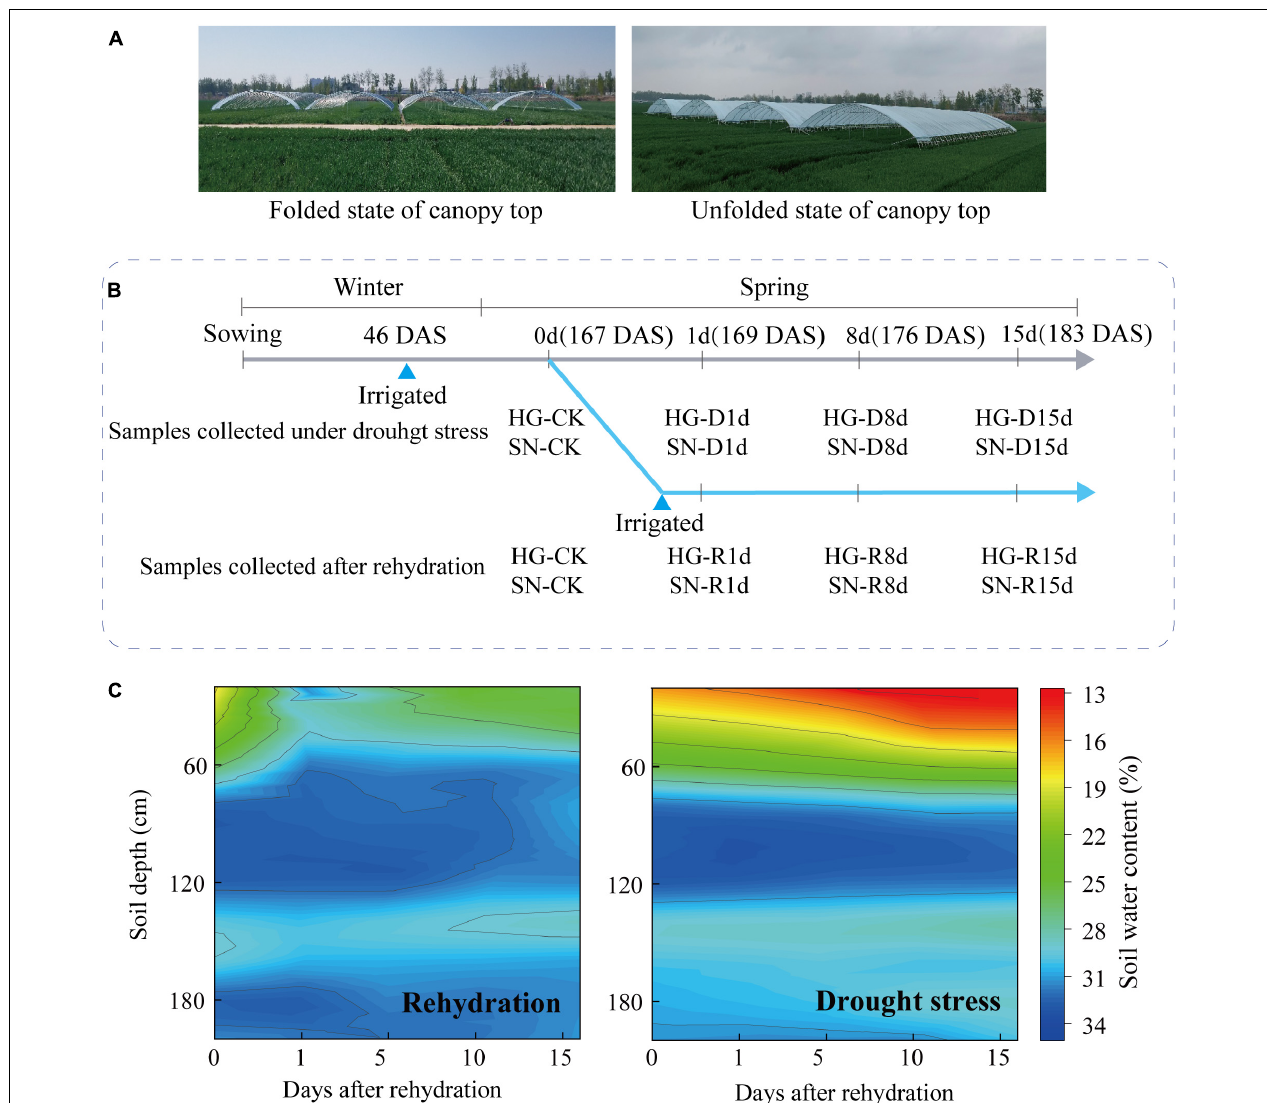
FIGURE 1 | Schematic representation of rehydration experimental design. (A) Rain shelter for field experiments. (B) Timeline for rehydration treatment and sample collection. (C) Profile of the relative soil-water content (RSWC) during different rehydration stages. Scale bar represents soil moisture content in percentage. R, rehydrated plants; D, plants under continuous drought